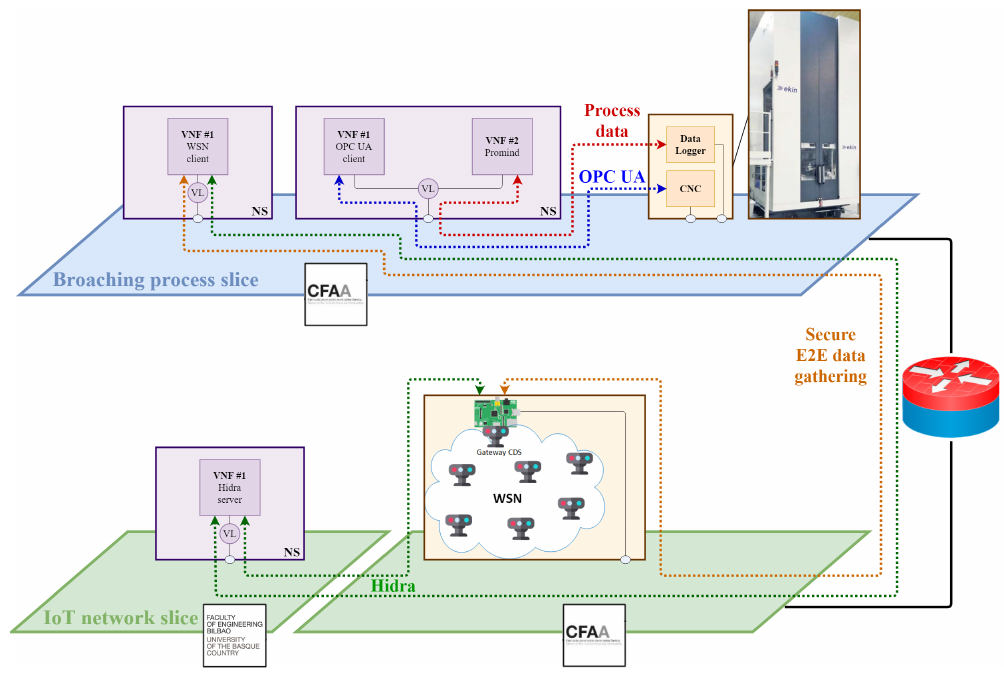
Figure 10. Global